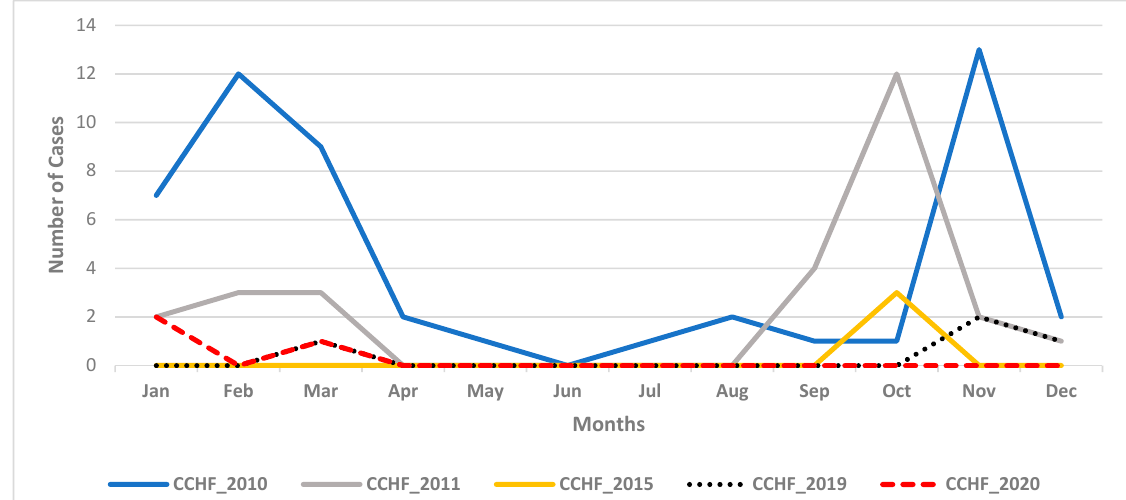
Months Figure 2. Epicurve showing Crimean-Congo hemorrhagic fever (CCHF) cases per month during the five epidemics between 2010 and 2020. In the 2010 epidemic, 40 cases of CCHF and 11 related deaths were reported in Sudan, of which 78% were from the Kordofan region, namely North and South Kordofan States (Figure 3). Six (12%) and five (10%) cases were reported from Khartoum State and the Darfur region, respectively (Figure 3). Interestingly, in 2010, CCHFV infections were re- ported for the first time from the Darfur region (Figure 3). Compared to the 2010 outbreak, the 2011 outbreak was less severe in terms of the number and severity of cases and the limited geographical distribution in the Kordofan region (Figure 3), with a total of 27 cases including a single fatality. Of these, 22 cases (81%) were reported from North Kordofan State, and 5 cases (19%) were reported from South Kordofan State (Figure 3). Three cases were reported in 2015 from East Darfur State. In the 2019 and 2020 epidemics, four and three cases were reported, respectively, distributed between the Darfur and Kordofan re- gions (Figure 3).